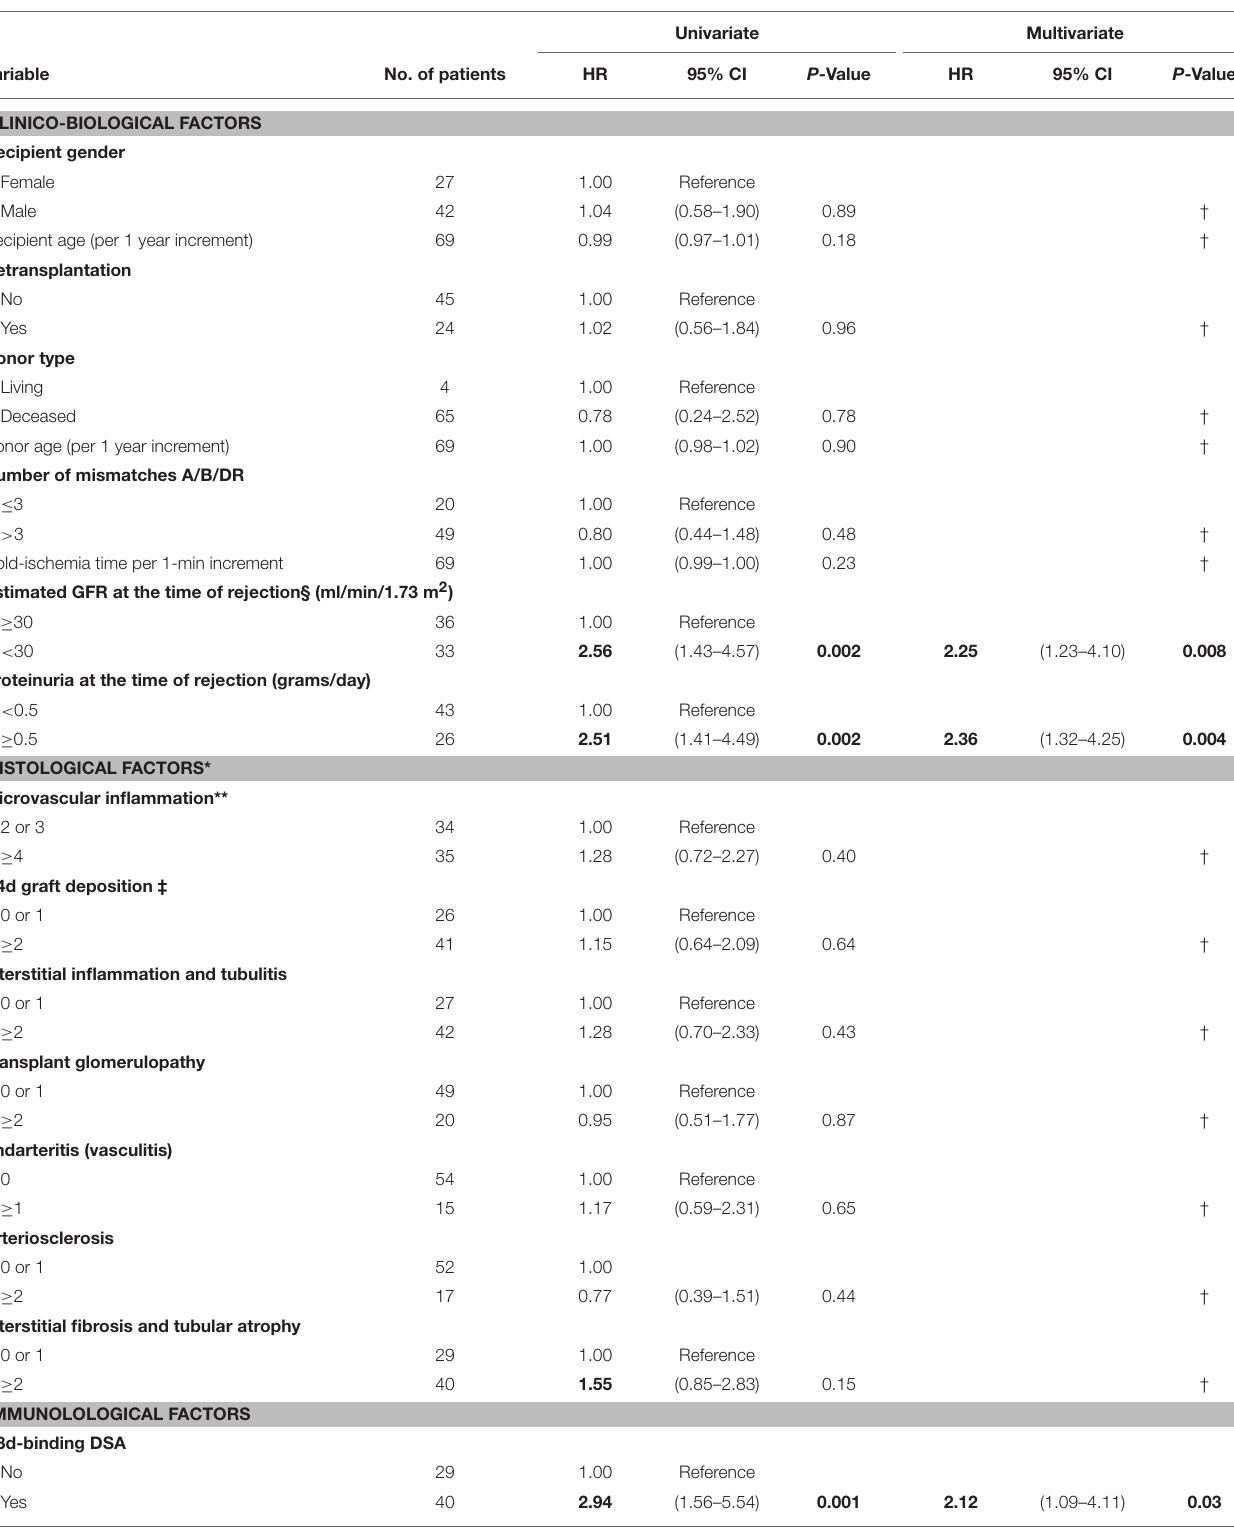
TABLE 3 | Univariate and multivariate analyses of risk factors for death-censored allograft loss.